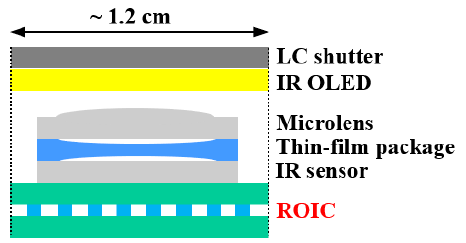
Figure 2. Monolithic IR camera chip.